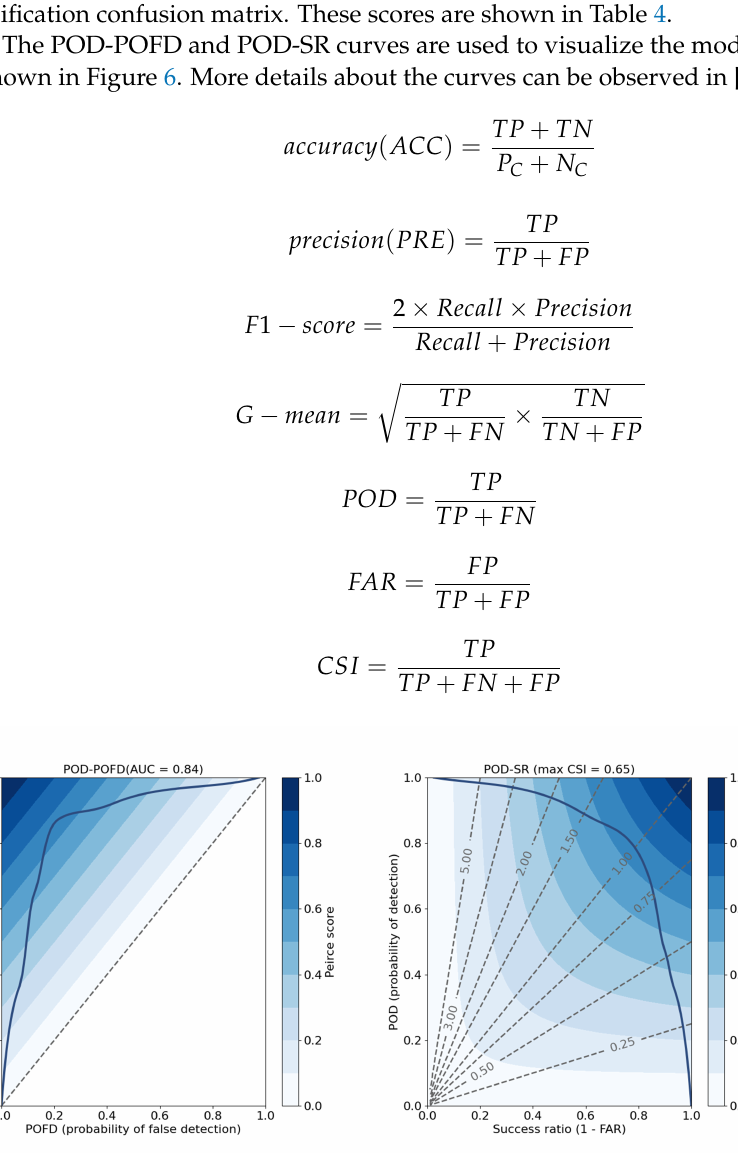
Figure 6. The POD-POFD and POD-SR curves on the testing set. The Area Under the Curve (AUC) is 0.84, and the maximum Critical Success Index (CSI) is